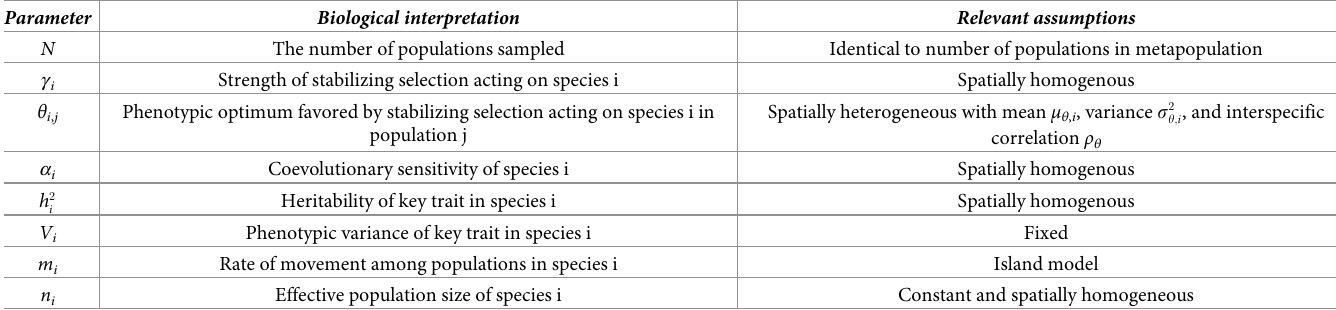
Table 1. Parameters, biological interpretations, and specific